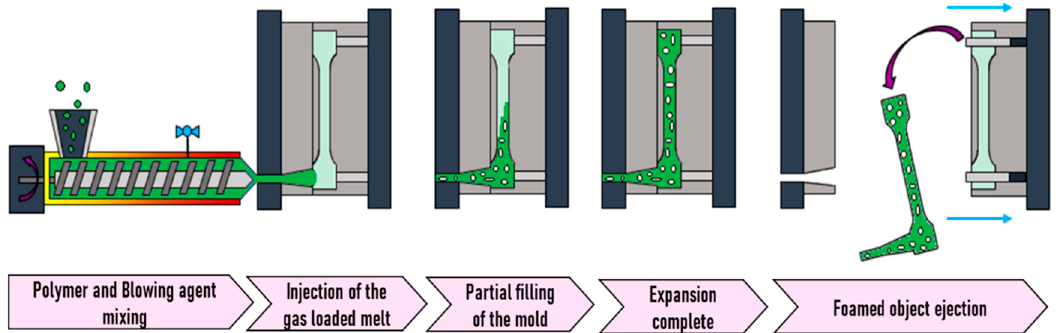
Figure 22. Principle of low pressure foam injection molding. Adapted from Standau et al. [132].